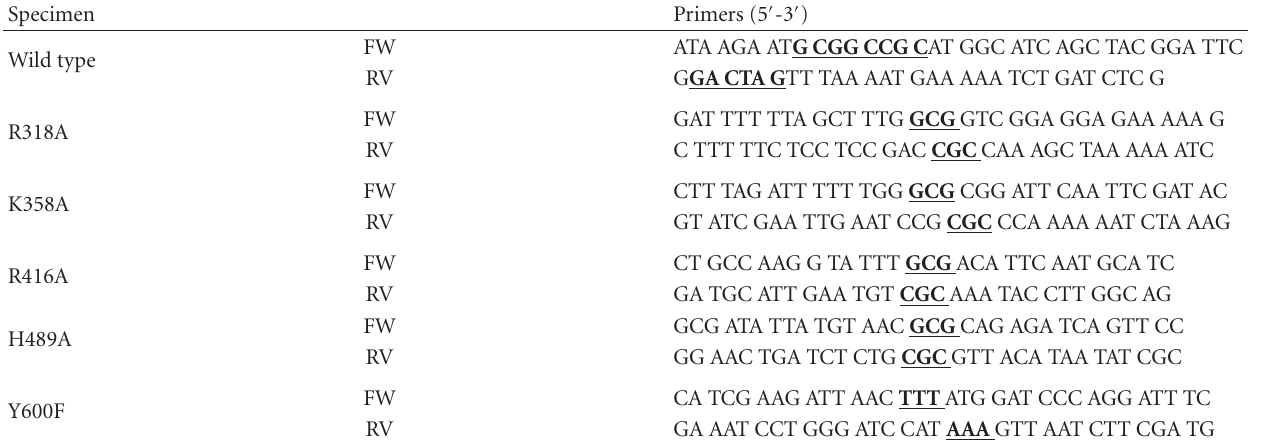
Table 1: Sequences of the primers used in this study to clone and to mutate CpTopIB.